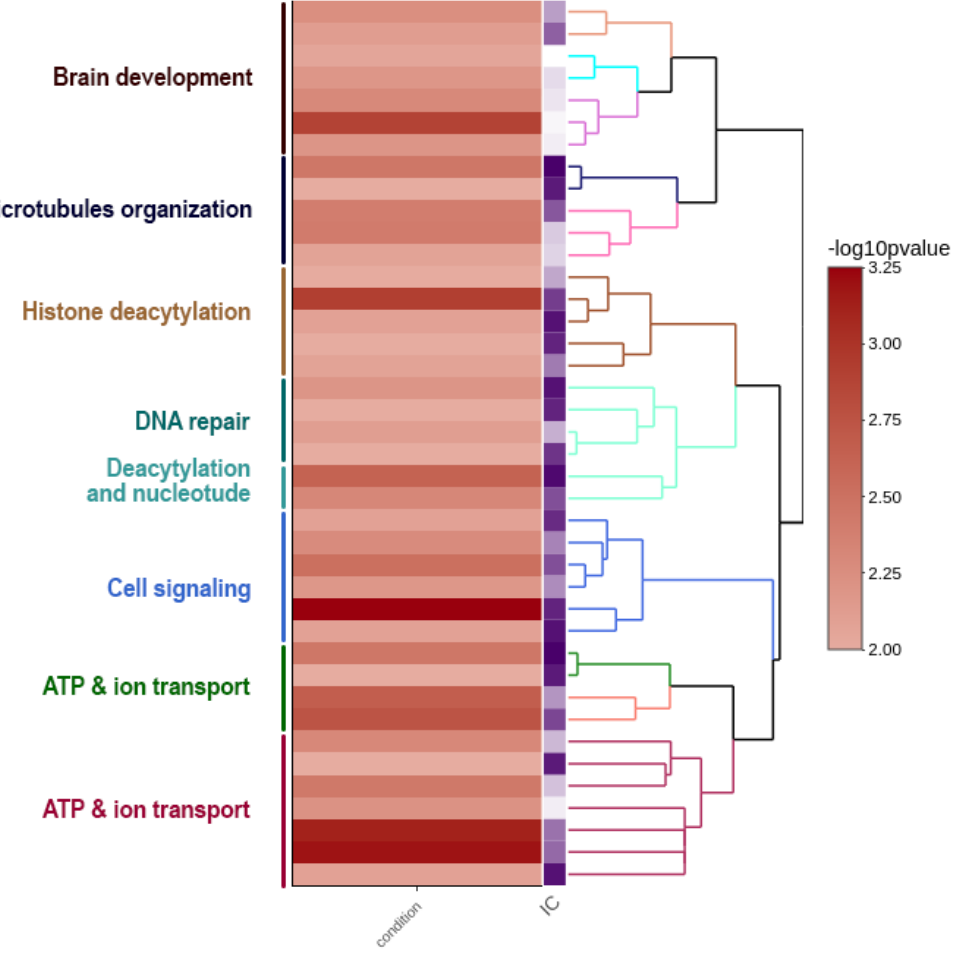
Figure 2. Gene ontology (GO) enrichment of annotated genes on the W chromosome of Indian cobra. Clustering heatmap plot with log 10 ( p -value) from functional enrichment tests and information content (IC). A higher log 10 ( p -value) represents a more enriched function. The results show that W chromosomes carry an enriched set of genes associated with development, histone deacetylation, signaling, and transport.